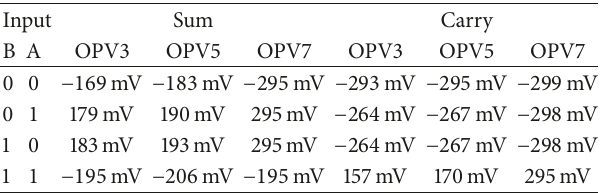
Table 1: Details on voltage levels for the HA in presence of different molecule